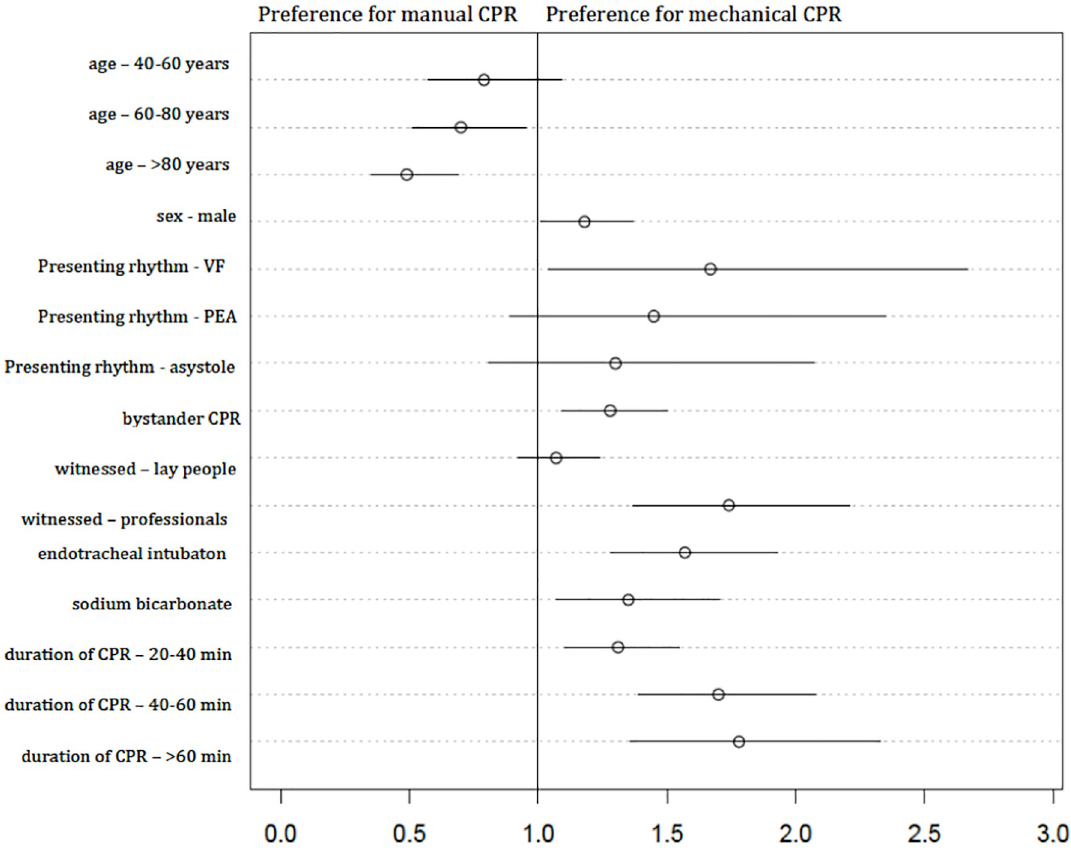
Fig 2. Factors influencing the choice to apply a mechanical CPR device. CPR = cardiopulmonary resuscitation; VF = ventricular fibrillation; PEA = pulseless electric activity.